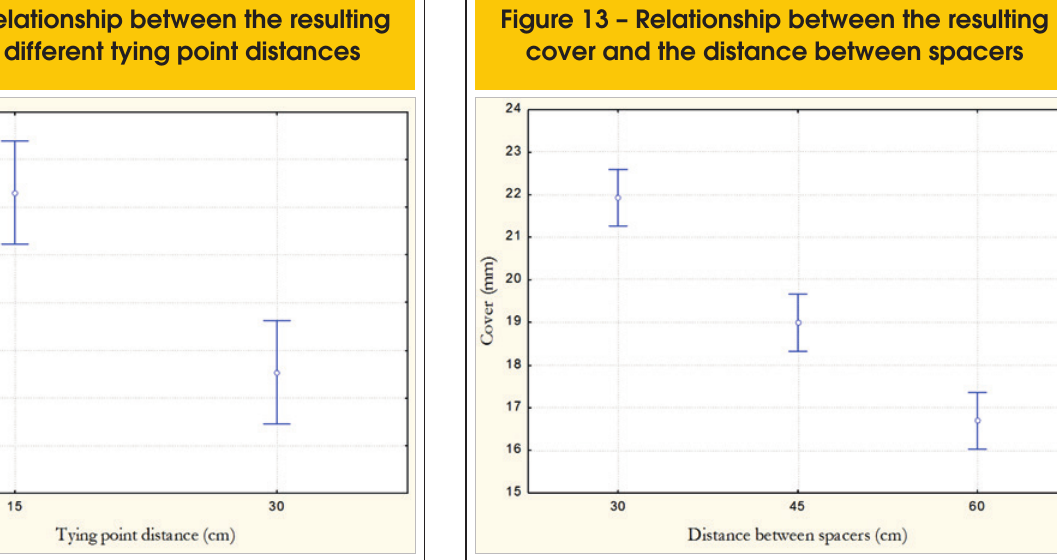
Figure 12 – Relationship between the resulting cover and different tying point distances